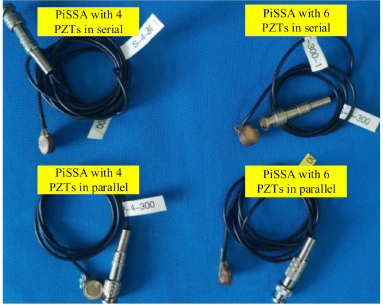
Figure 11. The four fabricated PiSSAs.